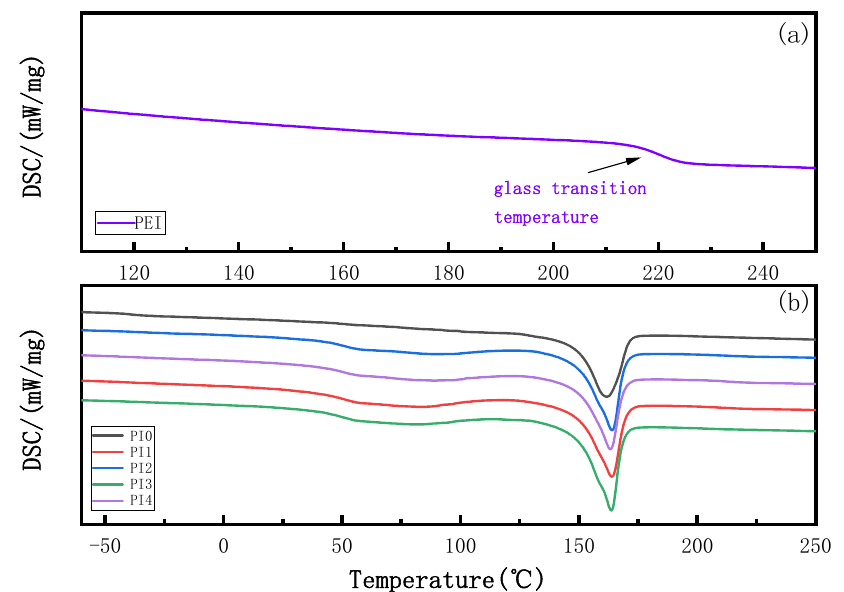
Table 4. DSC data of blend membranes.